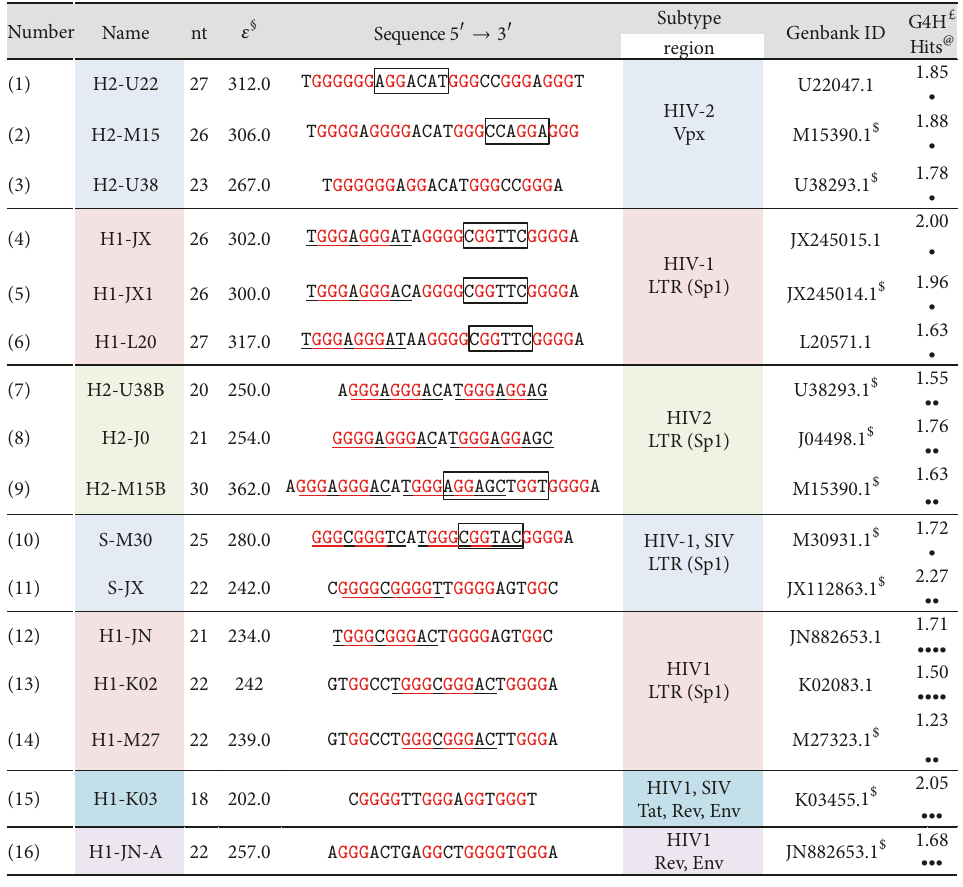
Figure 1: DNA oligonucleotides used in this study originating from HIVs and